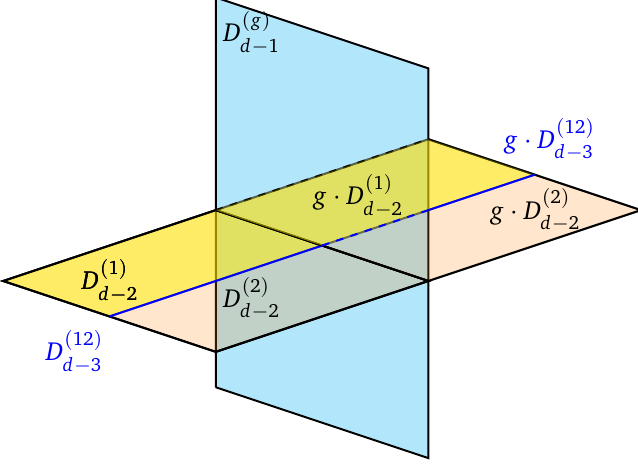
Figure 21: Action of the symmetry g P G on the defects D